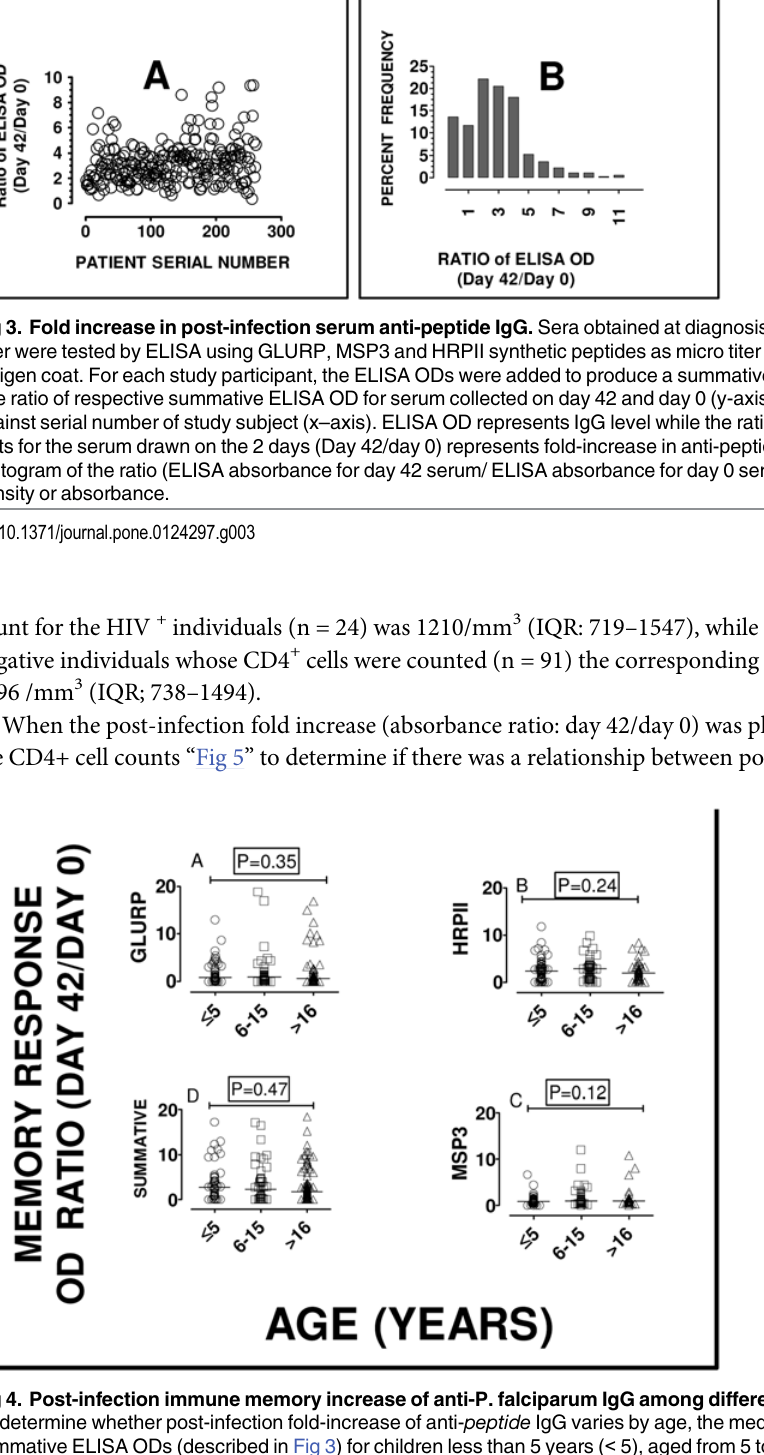
Fig 4. Post-infection immune memory increase of anti-P. falciparum IgG among different age groups. To determine whether post-infection fold-increase of anti- peptide IgG varies by age, the medians of summative ELISA ODs (described in Fig 3) for children less than 5 years ( < 5), aged from 5 to 16 years and older than 15 years ( > 16) were compared. There was no significant difference among the age groups for all three peptides. Kruskal Wallis test results: GLURP (H = 2.1, 2 df, P = 0.35; MSP3 (H = 2.9, 2 df, P = 0.24); HRPII (H = 4.3, 2 df, P = 0.12) and summative ELISA OD (H = 1.5, 2 d.f, P =